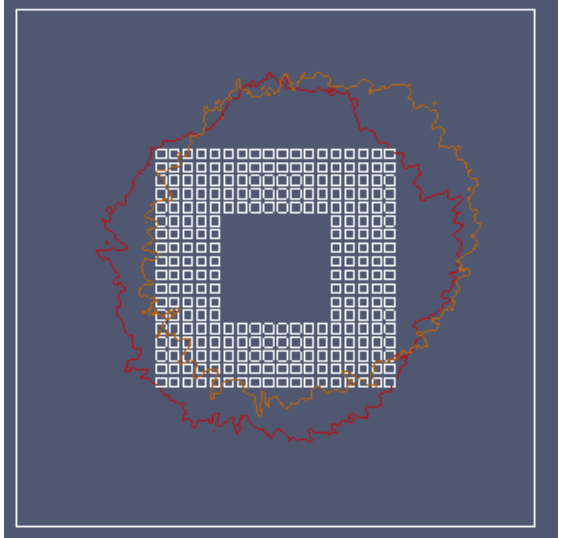
Figure 6. The 34 °C isotherm at a 0.5 m/s wind speed for the reference urban form (no buildings—orange line) and for UF 1 (red line)—the small white squares represent building